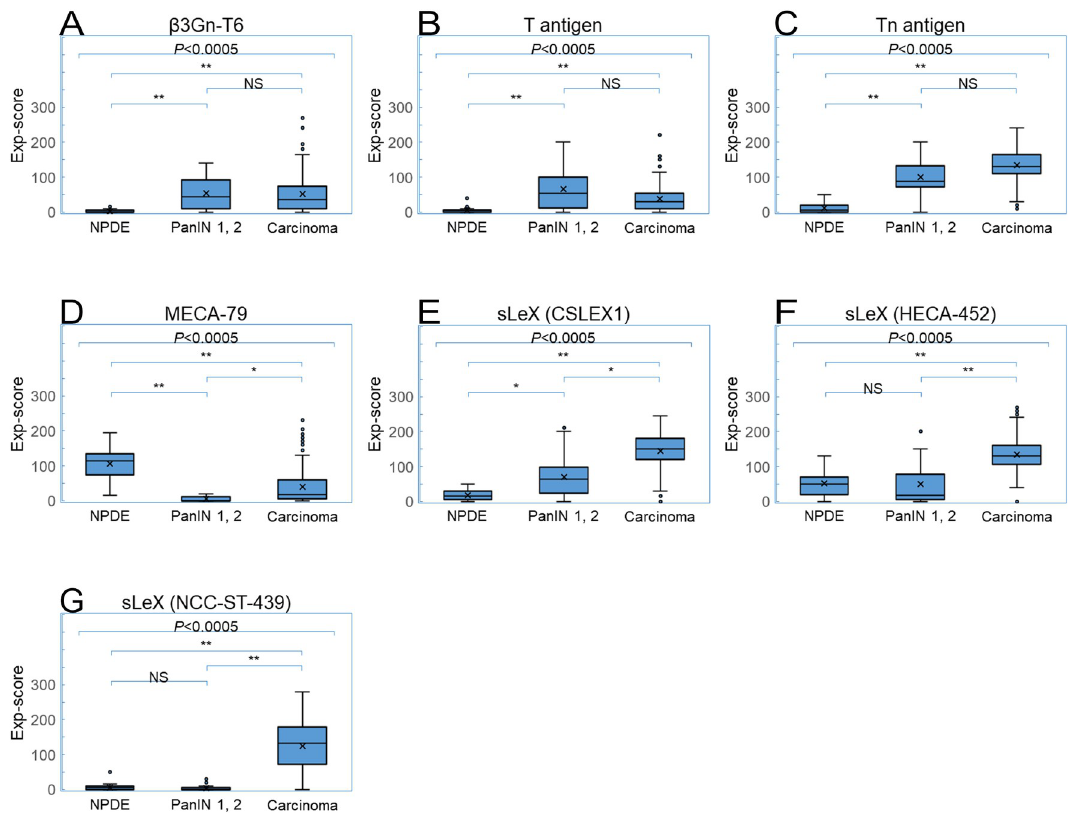
Fig 3. Comparison of glycan antigens and β 3Gn-T6 expression among PDACs (n = 156), PanINs (n = 26), and normal pancreatic tissues (n = 35). ((A) β 3Gn-T6, (B) T antigen (PNA), (C) Tn antigen (LU-35), (D) 6-sulfo N -acetyllactosamine on extended core 1 O -glycan (MECA-79), (E) sLeX (CSLEX1), (F) sLeX (HECA-452), and (G) sLeX on core 2 O -glycan (ST-439). Boxes represent medians and interquartile ranges. Crosses represent mean values. Whiskers represent the minimum and maximum 1.5 interquartile ranges. Circles represent extremes. All glycan antigens, except MECA-79 antigen, are expressed significantly more highly in PDAC cells than in NPDEs. MECA-79 antigen expression in PDAC cells is significantly lower than that in NPDEs. Exp-scores were compared and analyzed using the Friedman’s